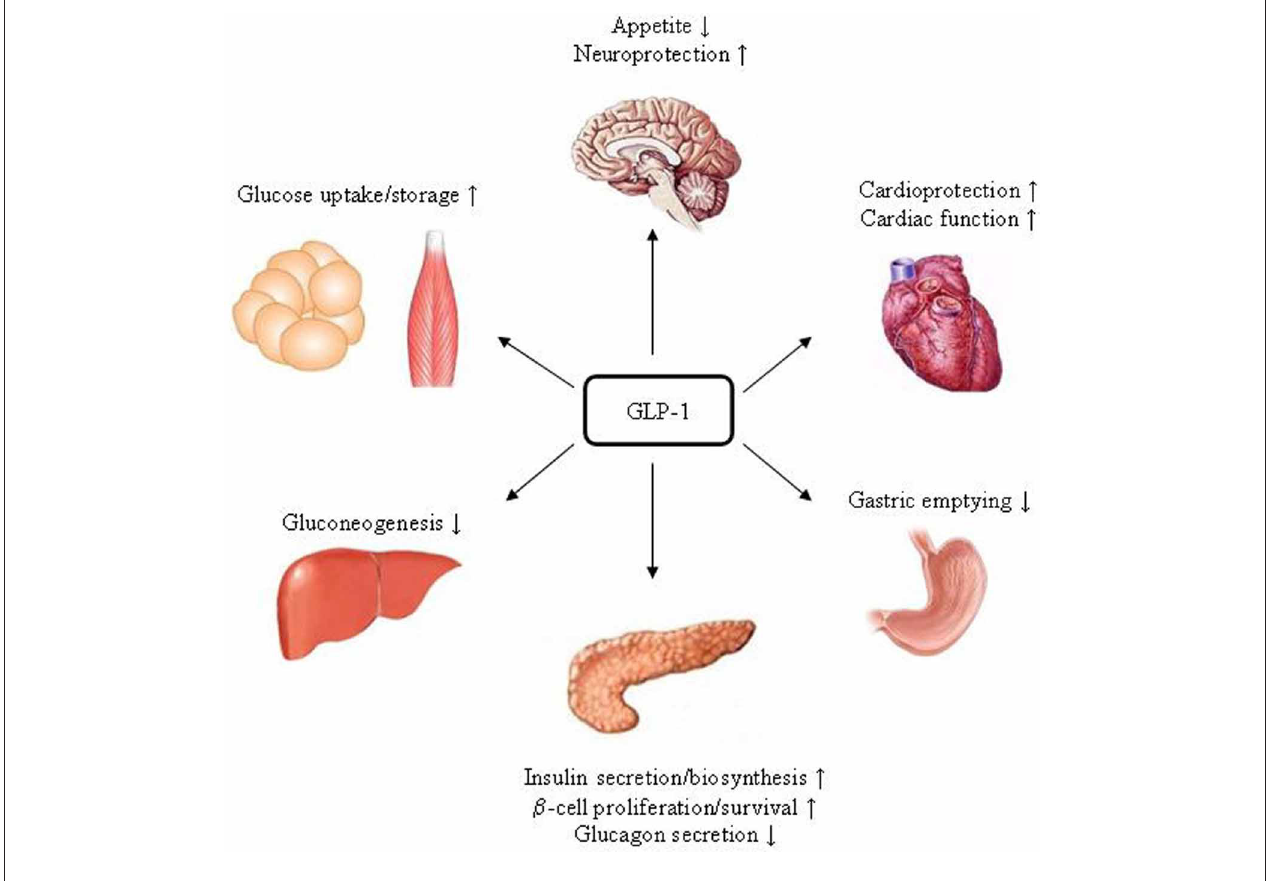
FIGURE 3 | Schematic presentation of the function of GLP-1. In the pancreas, stomach, heart and brain, the effects of GLP-1 are likely to be mediated by its specific receptor GLP-1R. As GLP-1 9 − 37